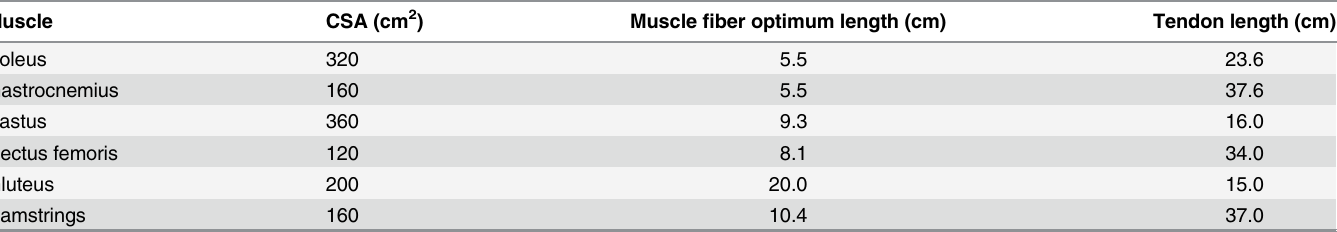
Table 4. Muscle parameters. Muscle cross-sectional area (CSA), muscle fiber optimum length and tendon element slack length of the reference model.